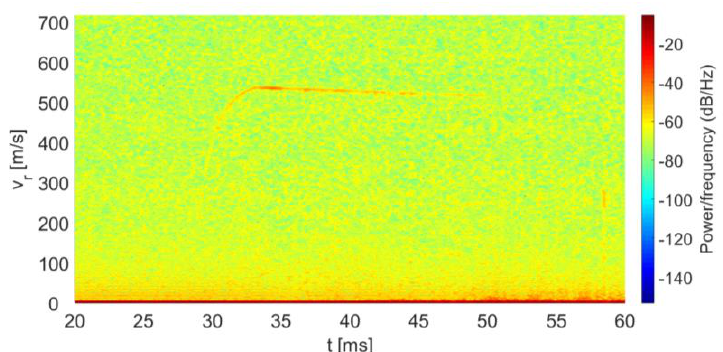
Figure 15. The instantaneous velocity of the fired bullet as a function of time.